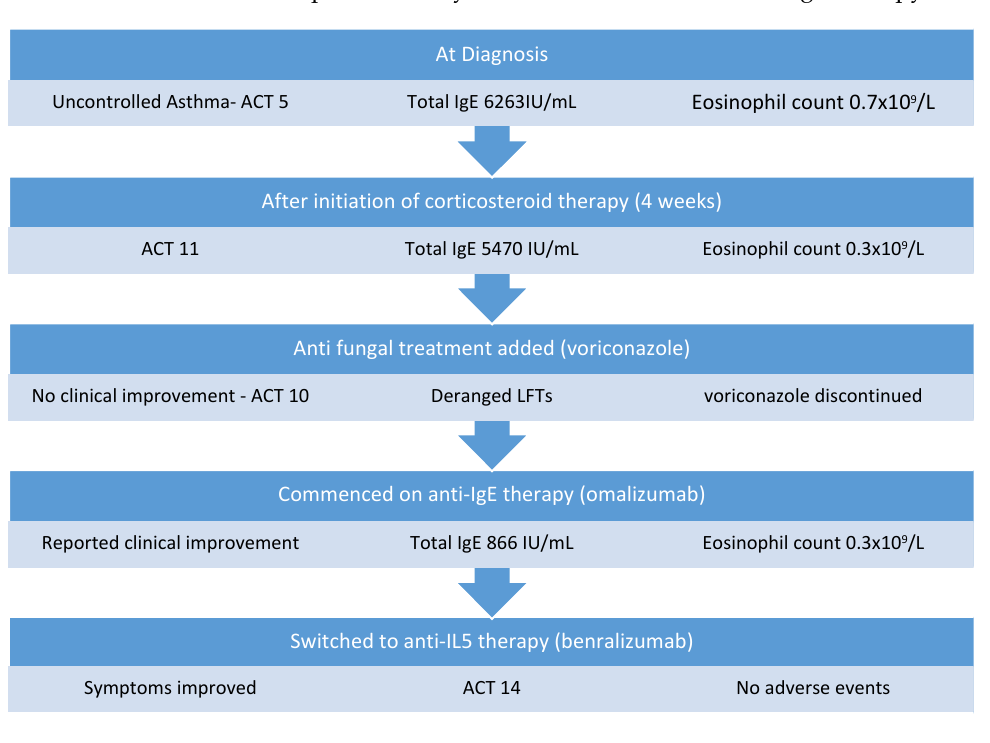
Figure 1. Management of Case 1.